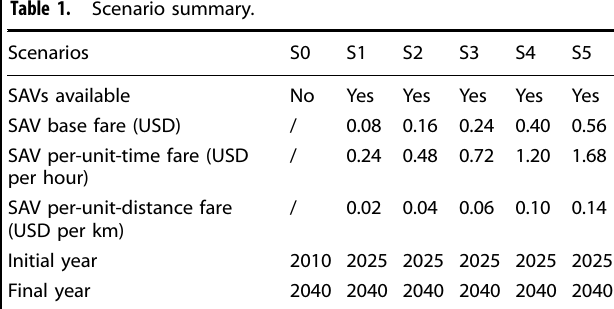
Table 1. Scenario summary.